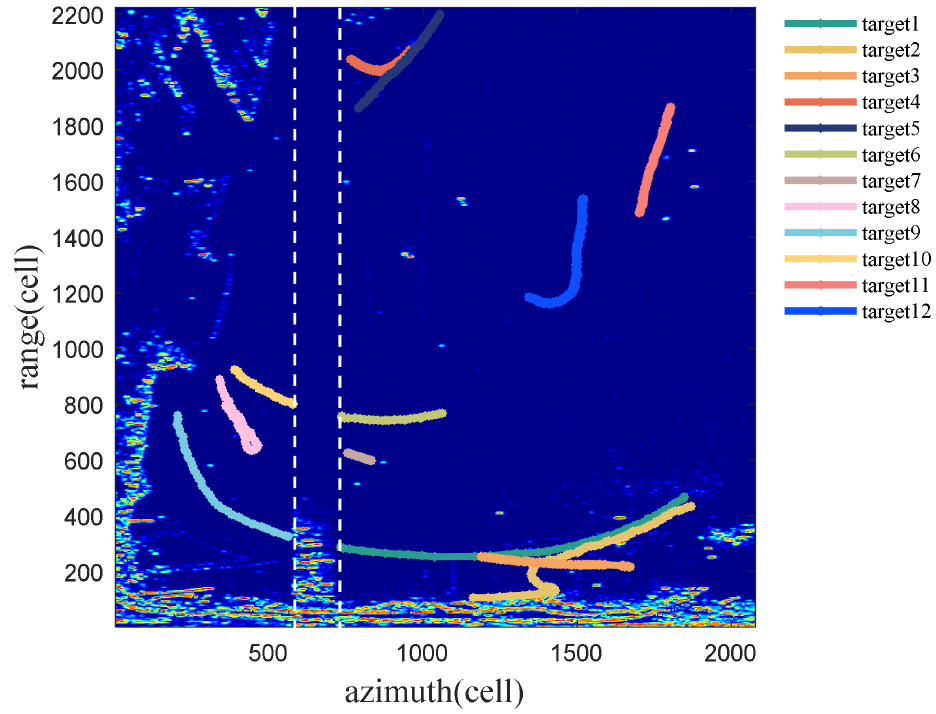
Figure 3. Twelve trajectories of moving targets by manually labeled.